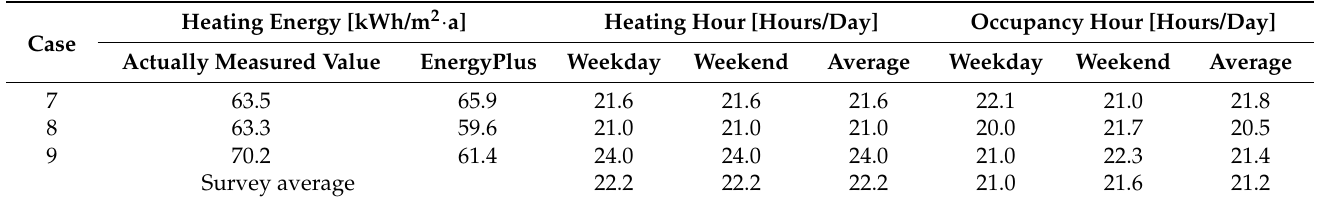
Table 13. Survey results of heating energy, heating hour, and occupancy hour (Case 7-9).